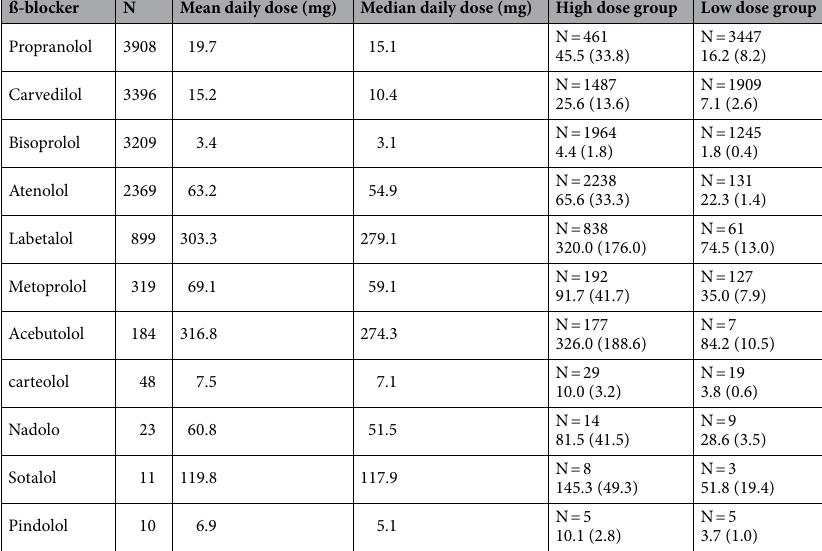
Table 4. The mean daily dose use of ß-blocker in both high dose and low dose group after propensity score matching. we defined the mean daily dose greater or equal to Carvedilol 12.5 mg qd and its equivalent dose as high dose group.